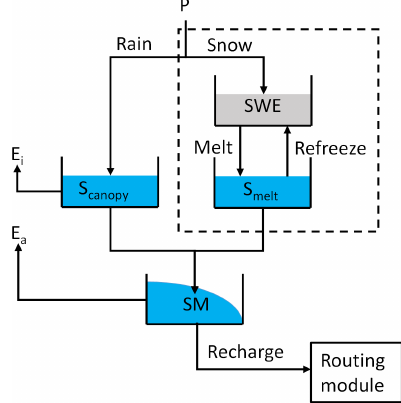
Figure 4. Illustration of the HBV model used for the reconstruc- tion of soil moisture and snow water equivalent. The dashed box illustrates the snow